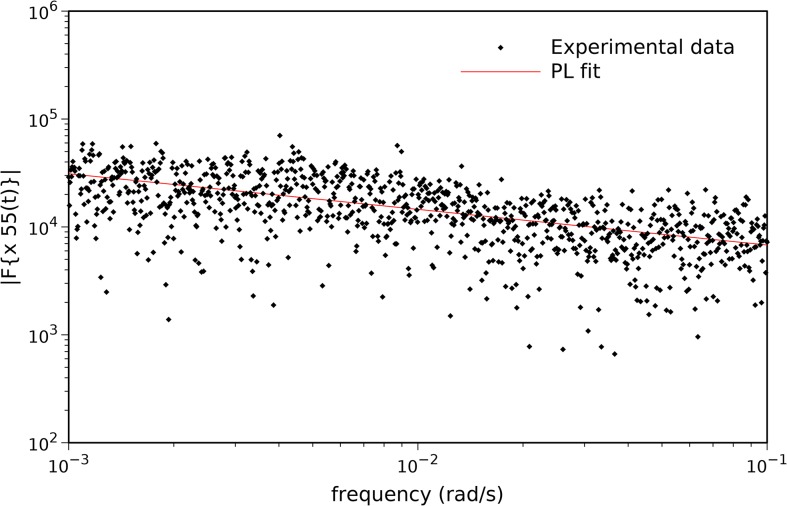
Magnitude of the Fourier transform, |F{x
55(t)}|, and PL approximation for the time series representation of tornadoes path length, L, in year 2005.